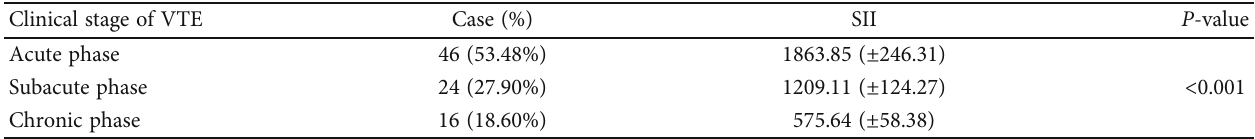
Table 3: SII levels of patients with VTE at di ff erent